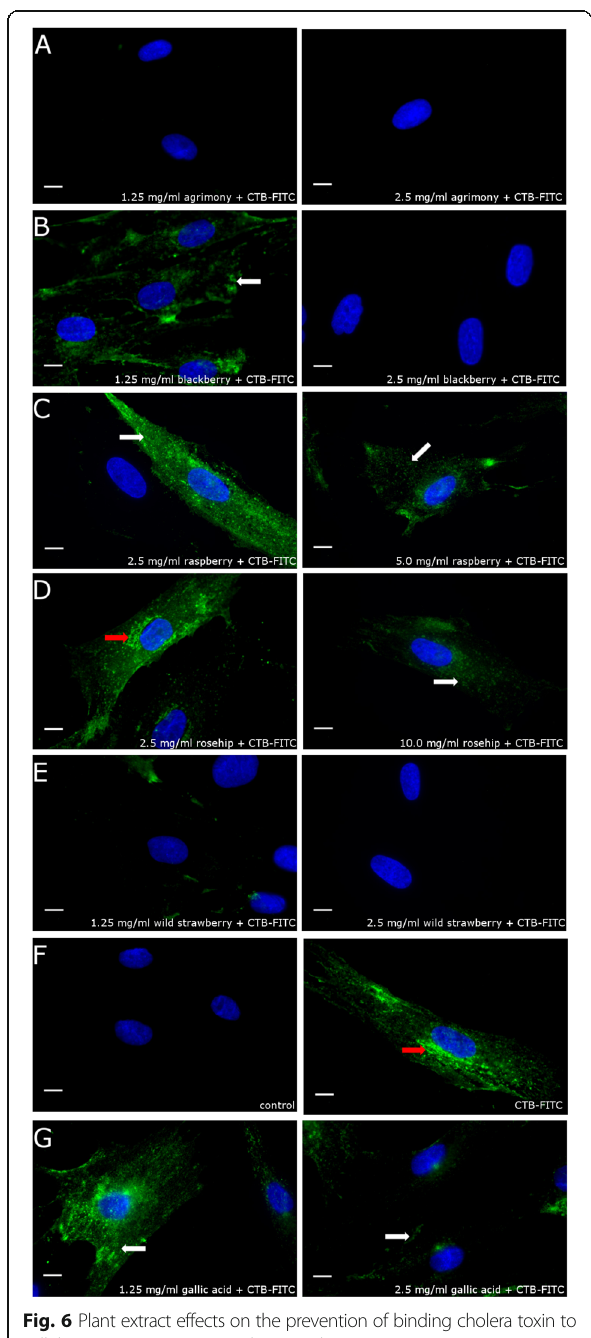
Fig. 6 Plant extract effects on the prevention of binding cholera toxin to cellular receptors or its internalization. Fluorescent microscope assay showing the CTB-FITC (green) labeling of fibroblasts after incubation with 2.5 and 1.25mg/mL of: a agrimony, b blackberry leaf, c raspberry leaf, d rosehip; 2.5 and 10mg/mL, and e wild strawberry leaf; 2.5 and 5.0mg/ mL . As controls f , we used (1) untreated cells and (2) incubated only with CTB FITC and g incubated with 1.25 or 2.5mg/mL gallic acid, and CTB-FITC. The nuclei of the analyzed cells were stained by DAPI (blue). The red arrows show toxin accumulated in the Golgi apparatus (see Additional file 2 for co-localization with a Golgi marker), while white arrows show toxin bound to the cell surface. Scale bar is 10 μ